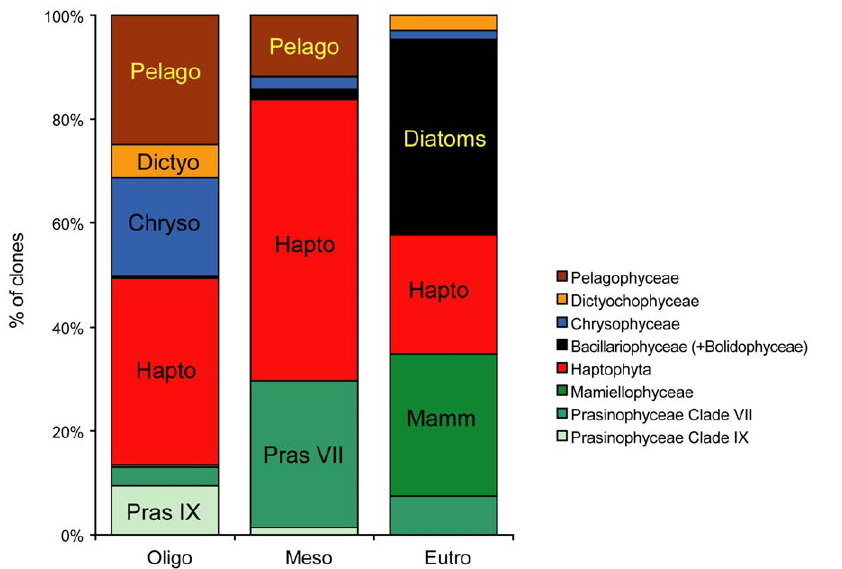
Figure 7. Overall composition of the photosynthetic picoeukaryote community for the three major regions considered. Composition is expressed as percent of clones. This synthetic figure is based on a compilation of the four approaches used: 16S plastid primer sets OXY107F/ OXY1313R and PLA491F/OXY1313R on sorted material (this study), 16S plastid primer set PLA491F/OXY1313R on filtered material [9] and 18S nuclear primers on sorted material [12]. Oligo, Meso and Eutro correspond to the three major regions considered: oligotrophic, mesotrophic, and eutrophic. Stations included in the three regions are detailed in Table 1. Station MAR1 (off the Marquesas Islands), which was only analyzed in reference [9] has been included in the mesotrophic pool.